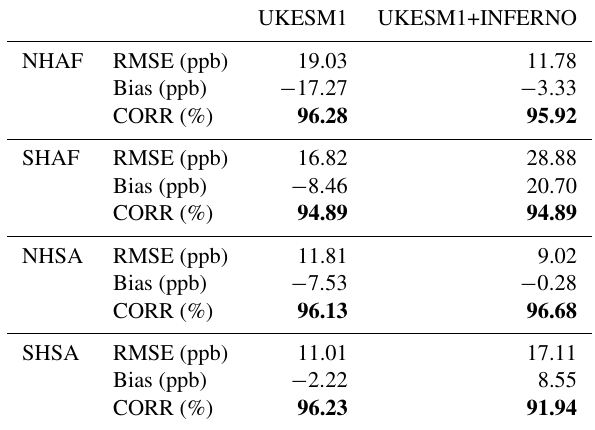
Table 3. Statistical comparison – root mean squared error (RMSE), bias and Pearson correlation coefficient (CORR) – of the monthly average time series between UKESM1 and UKESM1+INFERNO with TES-AURA for the period 2007–2012. Values in bold show that the correlation between a given experiment and TES-AURA is statistically significant with a 95% confidence level.